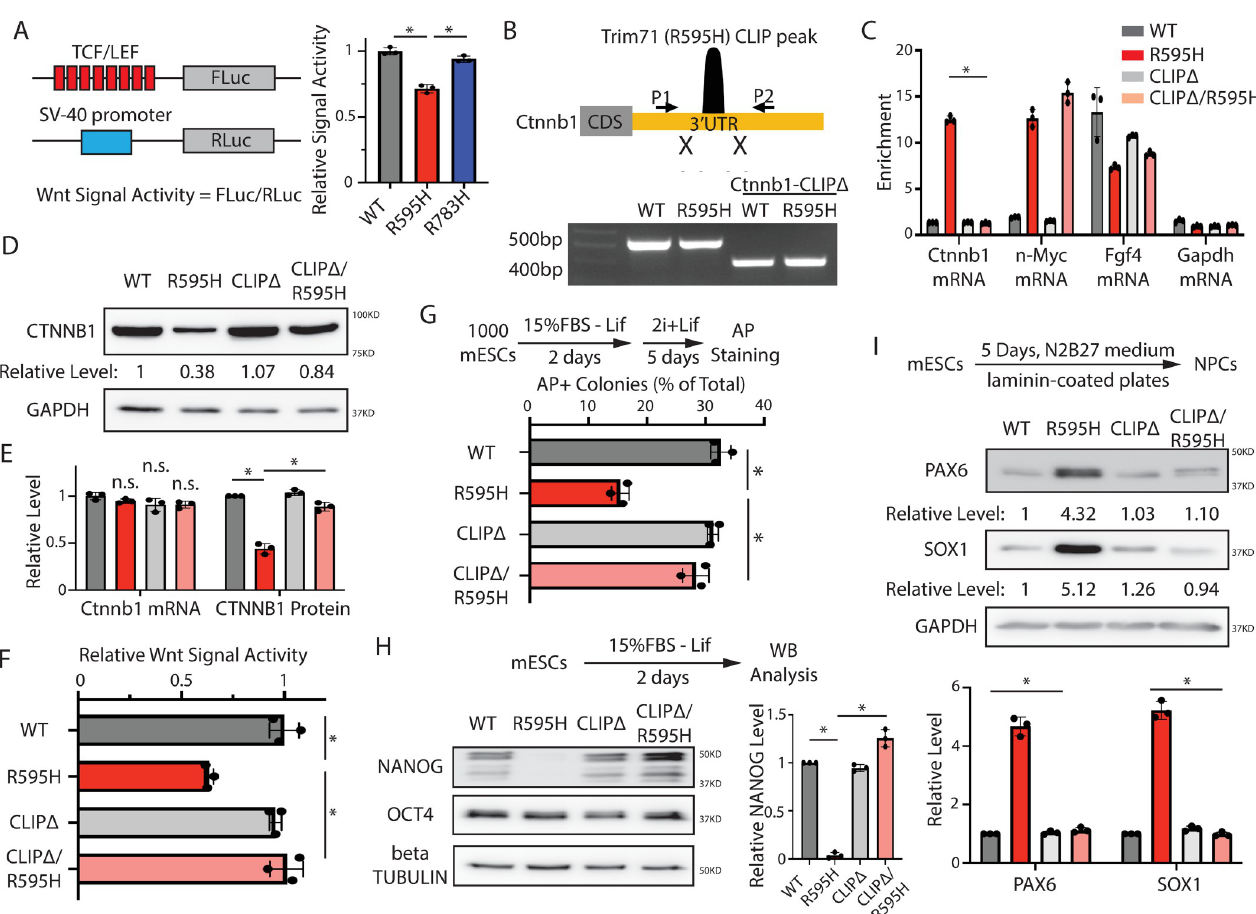
Fig 5. Disrupting the interaction between the Ctnnb1 mRNA and the R595H Trim71 specifically alleviates the differentiation defects in the R595H mESCs. ( A ) Measuring the Wnt signaling activity in the WT and the two mutant mESCs using a luciferase report. The cells were cultured in the 15% FBS + Lif medium. ( B ) Deletion of the R595H Trim71 binding site in Ctnnb1 mRNA’s 3 0 UTR. ( C ) CLIP-RIP followed by qRT-PCR to examine mRNAs associated with the WT Trim71 and the R595H Trim71 in the WT, R595H, CLIP Δ , and R595H/CLIP Δ mESCs. The mRNA signals from the E14 mESCs were set as 1 for relative comparison. The cells were cultured in 2i + Lif medium. ( D , E ) Western blotting and qRT-PCR quantifications in the WT, R595H, CLIP Δ , and R595H/ CLIP Δ mESCs. GAPDH and 18S rRNA were used for normalization in protein and mRNA quantifications, respectively. The cells were cultured in 2i + Lif medium. ( F ) Measuring the Wnt signaling activity in WT, R595H, CLIP Δ , and R595H/CLIP Δ mESCs using the luciferase assay. The cells were cultured in 15% FBS + Lif medium. ( G ) Exit pluripotency assay for mESCs. ( H ) Western blotting of pluripotency factors during the spontaneous differentiation of mESCs. ( I ) Western blotting of neural lineage markers during the directed neural differentiation. All the quantification results represent the means ( ± SD) of three independent experiments. � p < 0.05; and n.s. not significant ( p > 0.05) by one-way ANOVA. See also S7 Fig. The data for A, C, and E-H are available in S4 Data. mESC, mouse embryonic stem cell; qRT-PCR, quantitative real-time PCR; WT, wild-type.